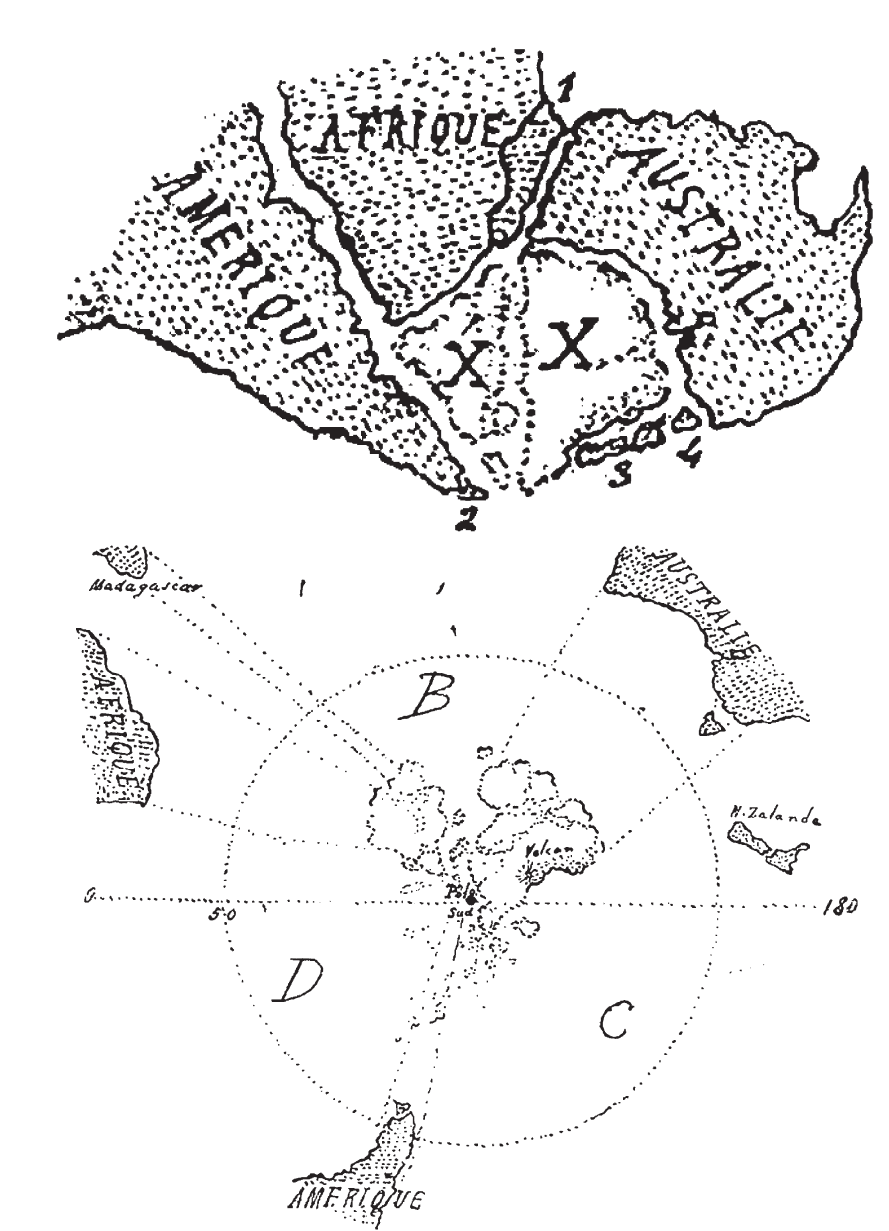
Fig. 6a,b. a) The continents reconstructed as a «supercontinent» by Mantovani in the work published on the magazine Je m’instruis in 1909. It is very similar to the Pangea depicted by Wegener starting from 1912. b) In the same paper on Je m’instruis the breakout of the continents away from Antarctica was depicted, which con- tinent was hypothesized by Mantovani as constituted by several islands. The hope of the Italian was that the An- tartic expedition of the explorer Jean-Baptiste Charcot (1867-1936) – to which the maps were given – could find evidences in favour of the real existence of an